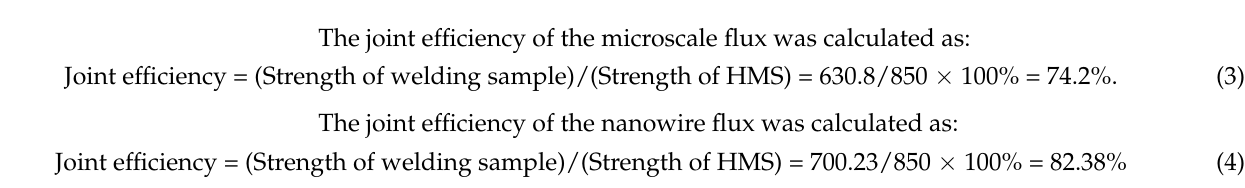
Figure 9. Tensile stress vs. tensile strain curve for the nanowire flux and microscale flux weld joint.